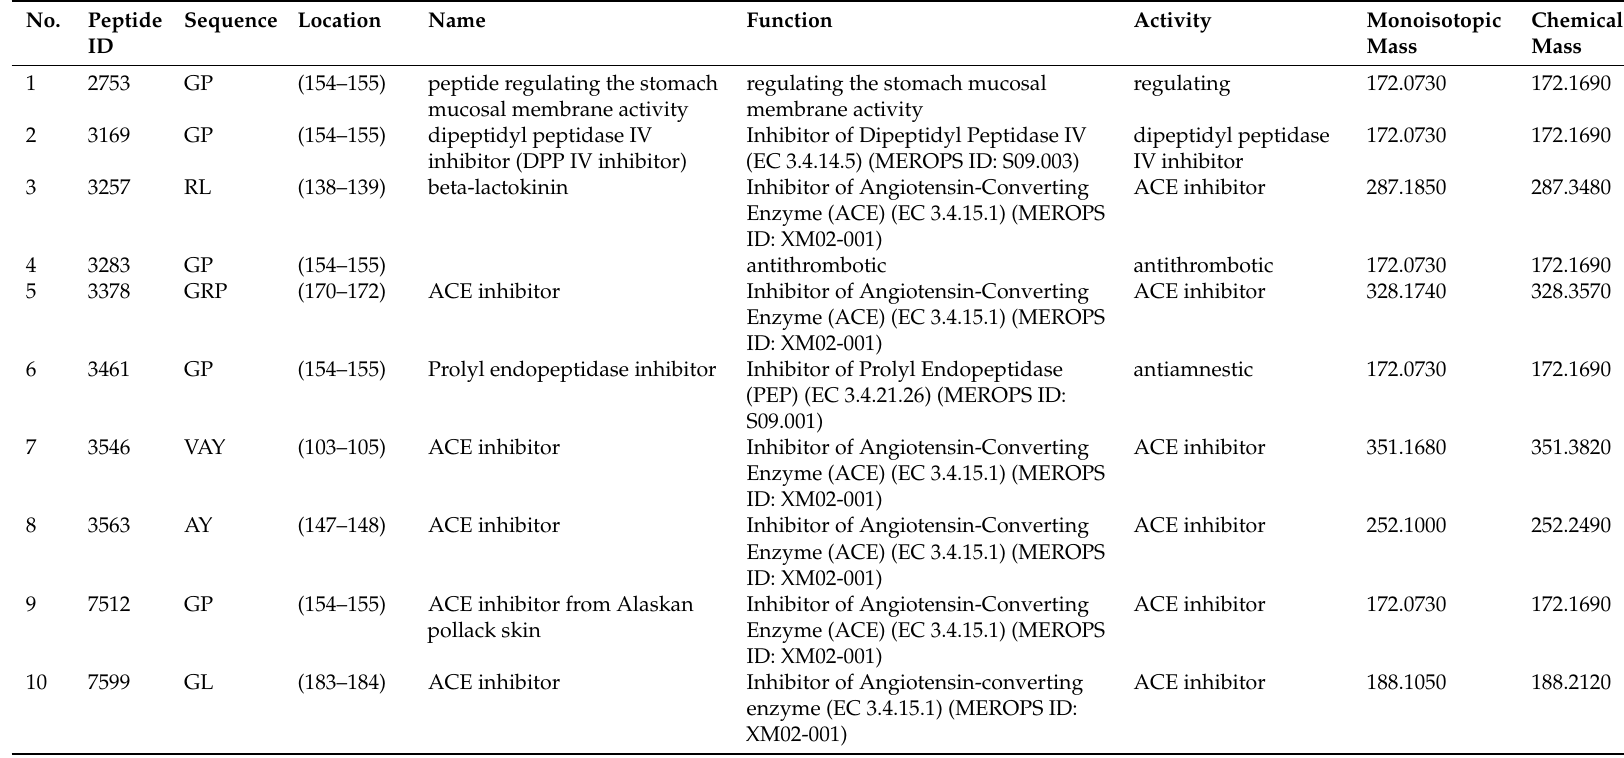
Table A17. Bioactive peptides from RubisCO of Halophila stipulacea . In silico enzymatic cleavage was carried out by using